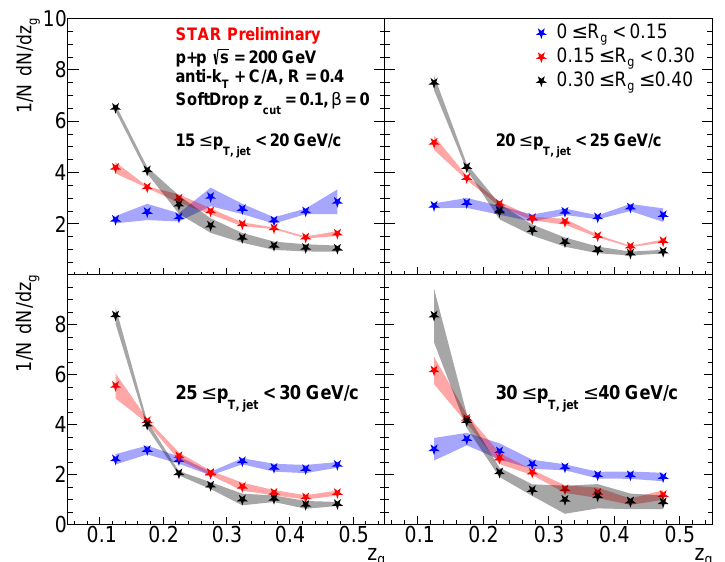
bins for jets with R = 0.4 in p + p g